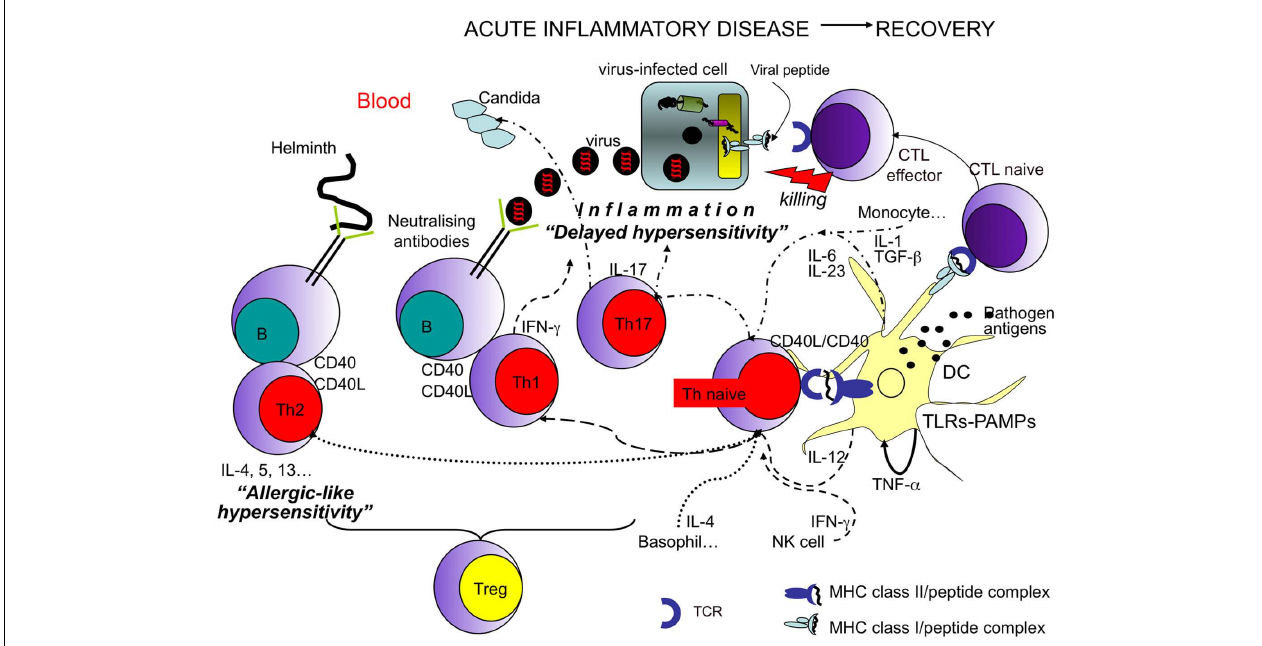
by both DCs and B cells, and CD40 ligand (L), expressed by activatedT cells.ThenTh1 cells display protective activity against intracellular pathogens (i.e., viruses ... ), via both IFN- γ production (antiviral activity) and by cooperating with B cells producing IgG1 (in humans) or IgG2 (in mice) neutralizing antibodies.Th2 cells are protective against extracellular pathogens, such as helminthes, via the production of a series of cytokines (e.g., IL-4, IL-5, IL-13) addressed to provoke “allergic-like” hypersensitivity (obtained via the recruitment of various cells, including eosinophils and mast-cells) and production of protective IgE antibodies by B cells.Th17 cells seem to be important in fighting extracellular pathogens, such as fungal infections. (CD8 + ) CytotoxicT lymphocytes (CTLs) directly kill infected cells via the recognition of class I molecules expressing pathogen peptides. In any case, activatedT cells can eliminate the pathogen via the establishment of a severe inflammatory disease.T reg cells control exaggerated responses or the emergence of autoreactive